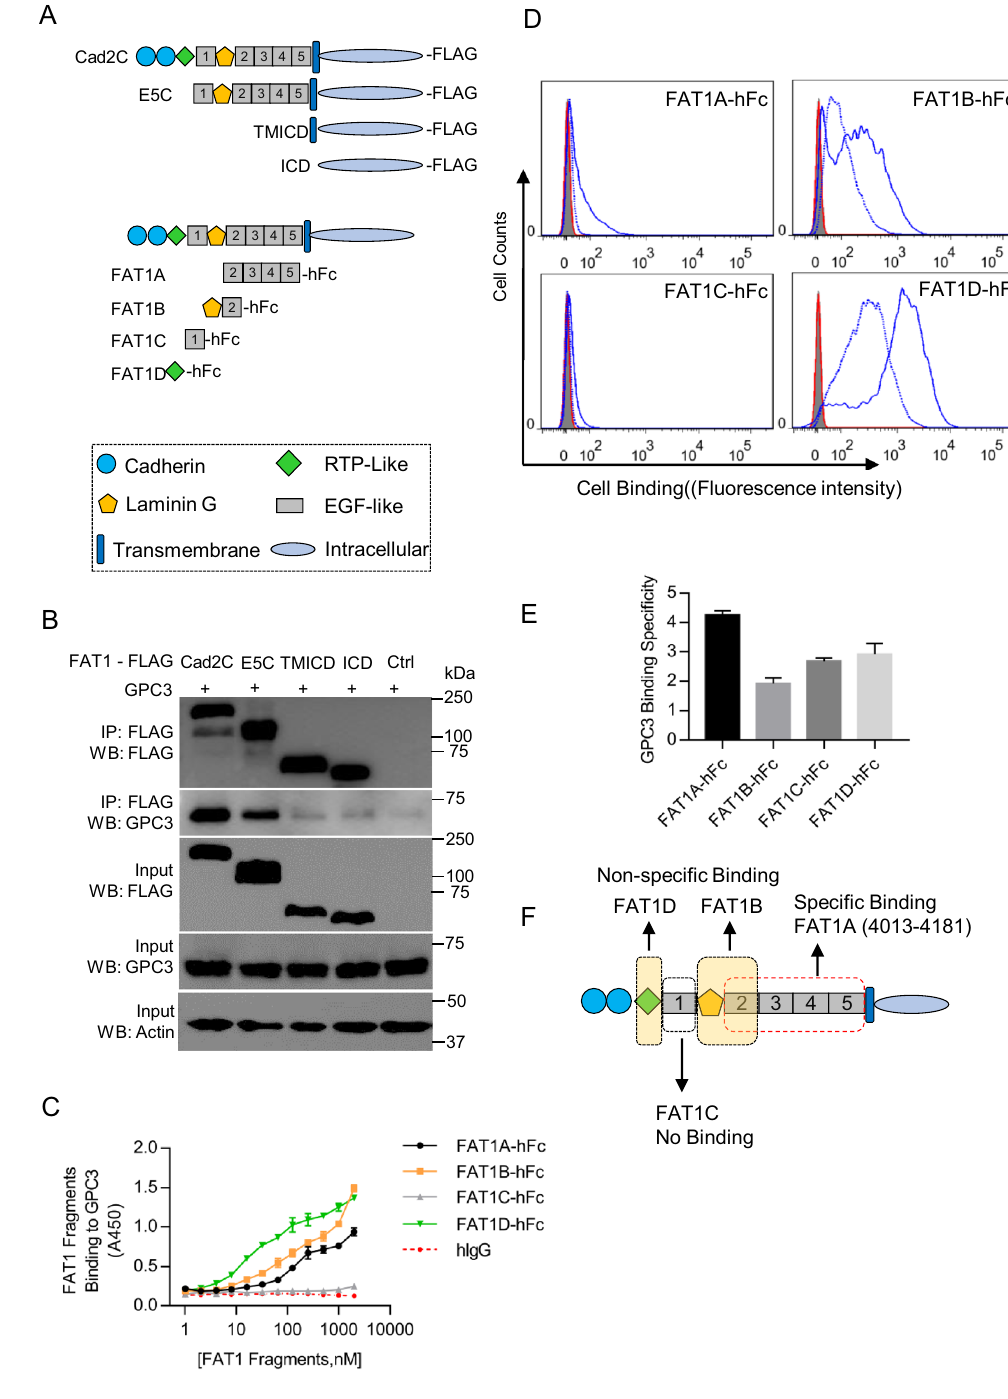
Figure 2. Mapping of the GPC3 binding region on FAT1. ( A ) Diagram of the FAT1 fragments, either with C-terminal FLAG tag for co-IP assays, or with C-terminal hFc tag for ELISA and FACS experiments. ( B ) Co-IP of GPC3 by FAT1 truncation fragments with C-terminal FLAG tag in 293 T cells. GPC3 and FAT1 truncation fragments were co-expressed in 293 T cells. FAT1 fragments were pulled down with anti-FLAG monoclonal antibody, and the co-immunoprecipitated GPC3 was probed with anti-GPC3 monoclonal antibody hYP7. Ctrl was an empty expression vector for FAT1 fragments. Full-length blots/gels were presented in Supplementary Figure S2. ( C ) ELISA analysis of recombinant FAT1 fragments binding to immobilized GPC3. GPC3-His was coated on the 96-well plate (5 μg/ml, 50 μl/well), and varied amount of FAT1 fragments was added to the wells. Pooled hIgG was used as isotype control. ( D ) Flow cytometry analysis of the binding specificity of the recombinant FAT1 fragments to cell surface GPC3. A pair of GPC3 negative A431 cell line and GPC3 over-expressing A431 (GPC3+) cells were tested by incubation with hFc-tagged FAT1 fragments (50 μg/ml). Blue solid line, FAT1 fragments staining on A431 (GPC3+) cells; Blue dashed line, FAT1 fragments staining on A431; red line, isotype control staining on A431 (GPC3+); Shaded area, isotype control staining on A431. ( E ) Binding specificity of recombinant FAT1 fragments to cell surface GPC3 that was calculated by the ratio of A431 (GPC3+) binding (geometrical mean of fluorescence intensity) versus A431, based on data from ( D ). Data represent mean ± SEM (n = 3). ( F ) Schematic diagram of the GPC3 binding region on FAT1 based on the above